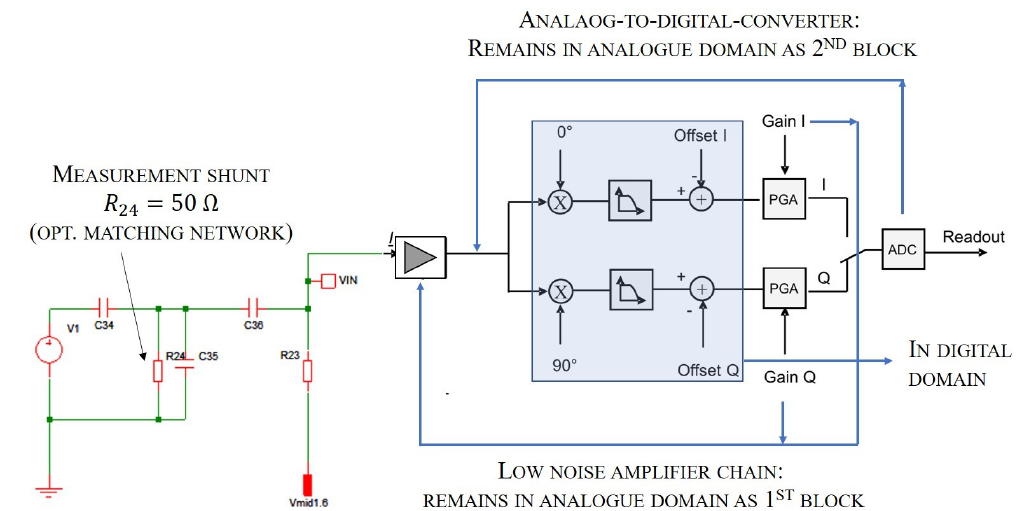
Figure 7. Read-out hardware